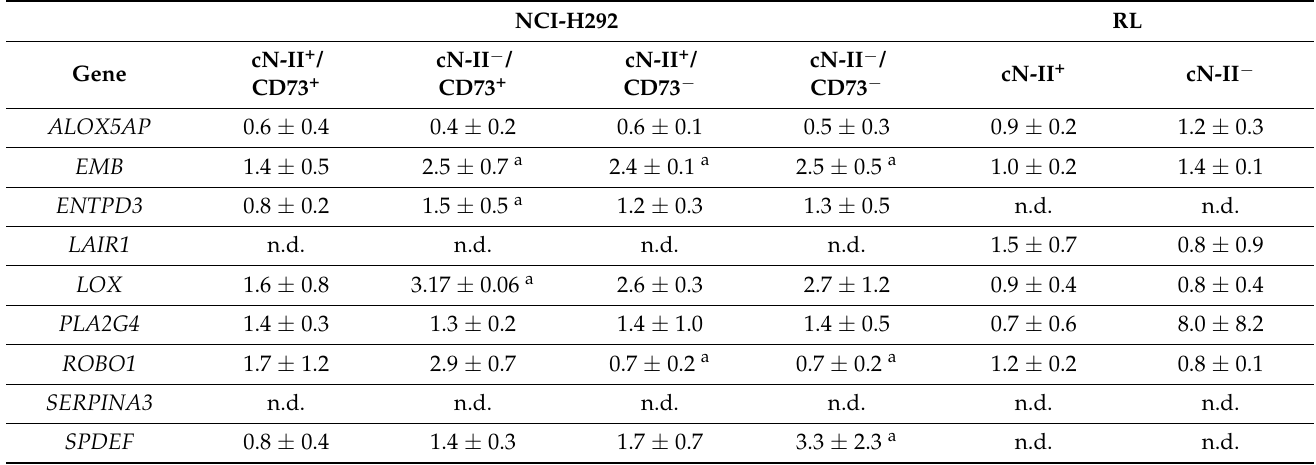
Table 2. Expression of certain studied genes in other cell models as determined by quantitative RT-PCR in unexposed cells. Values are means of four different samples ± standard deviation. a : p < 0.05 for comparison to cN-II + /CD73 + cells as determined by one-way ANOVA test. n.d.: not